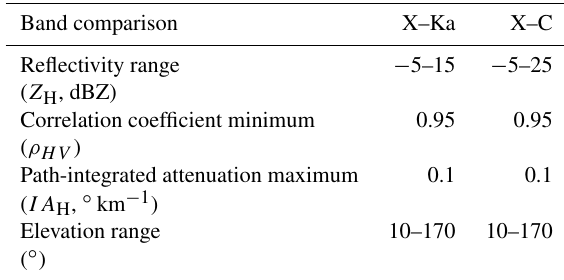
Table A2. Thresholds for weather and data selection used in radar reflectivity cross